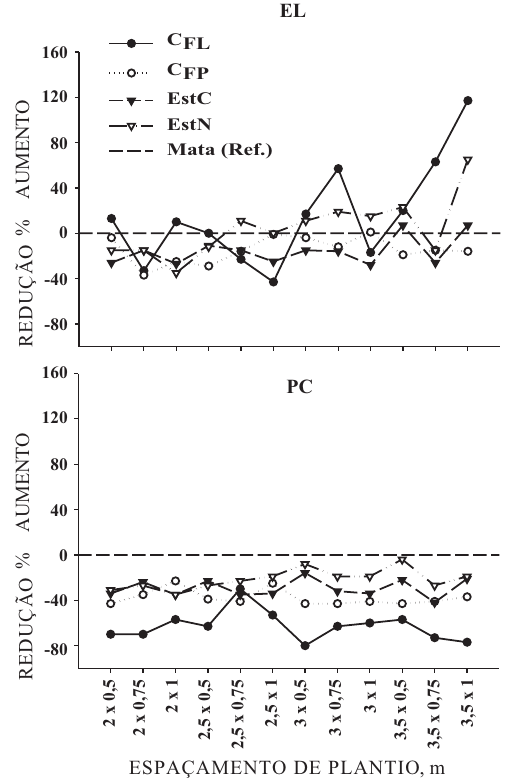
Figura 4. Aumentos ou reduções relativas de C- fração leve, C-fração pesada, estoque de CO e estoque de NT de um Latossolo Vermelho distroférrico típico cultivado com cafeeiro em diferentes de